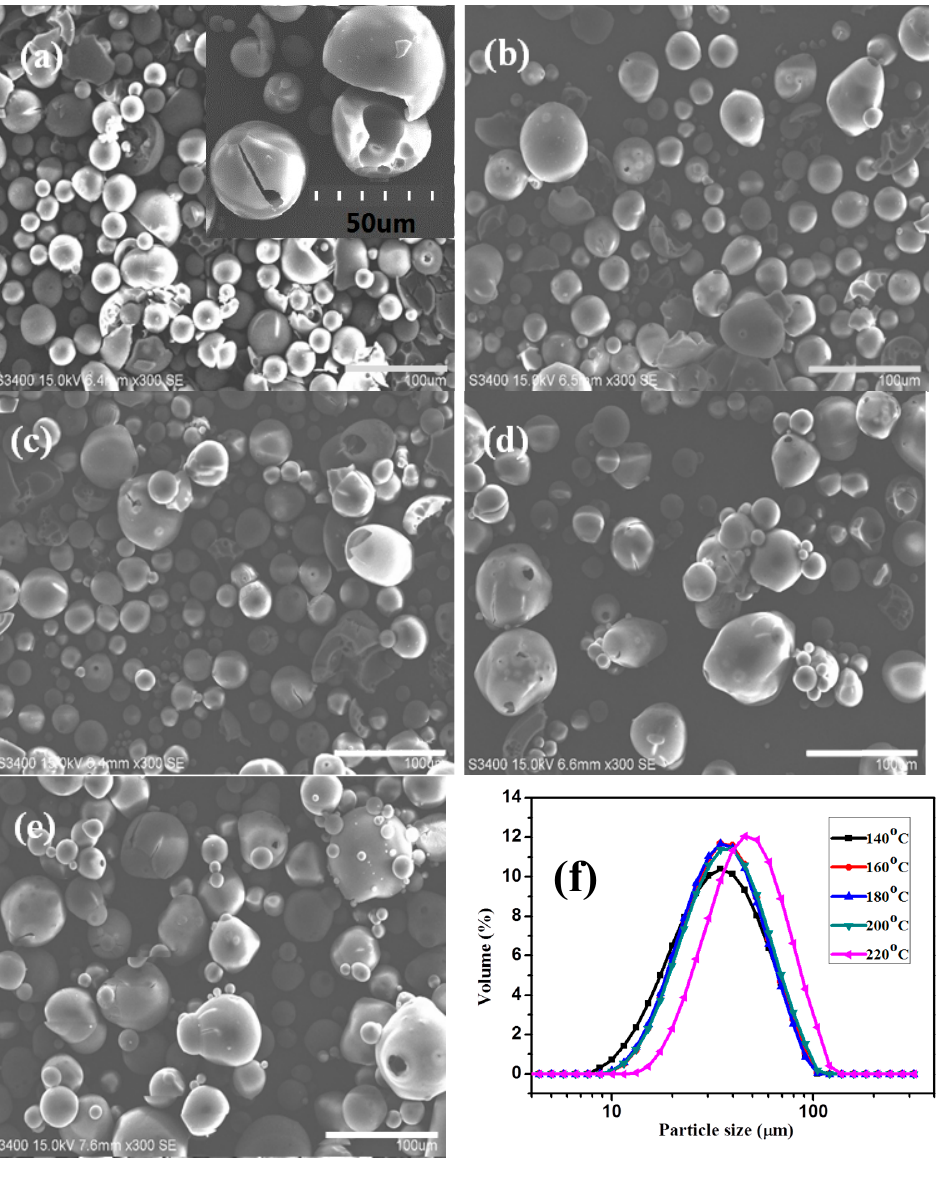
Figure 2. SEM images of the polyacrylate hollow microspheres prepared at different inlet temperatures: ( a ) 140 °C; ( b ) 160 °C, ( c ) 180 °C, ( d ) 200 °C, and ( e ) 220 °C; ( f ) Particle size distribution as a function of inlet temperature.